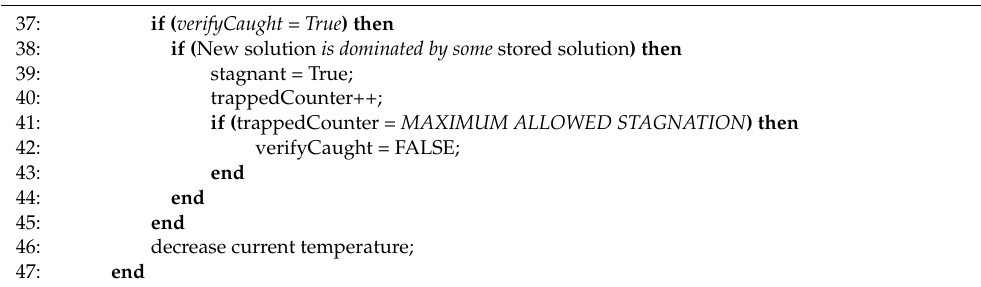
Algorithm 4. Improvement method: Chaotic Multi-Objective Threshold